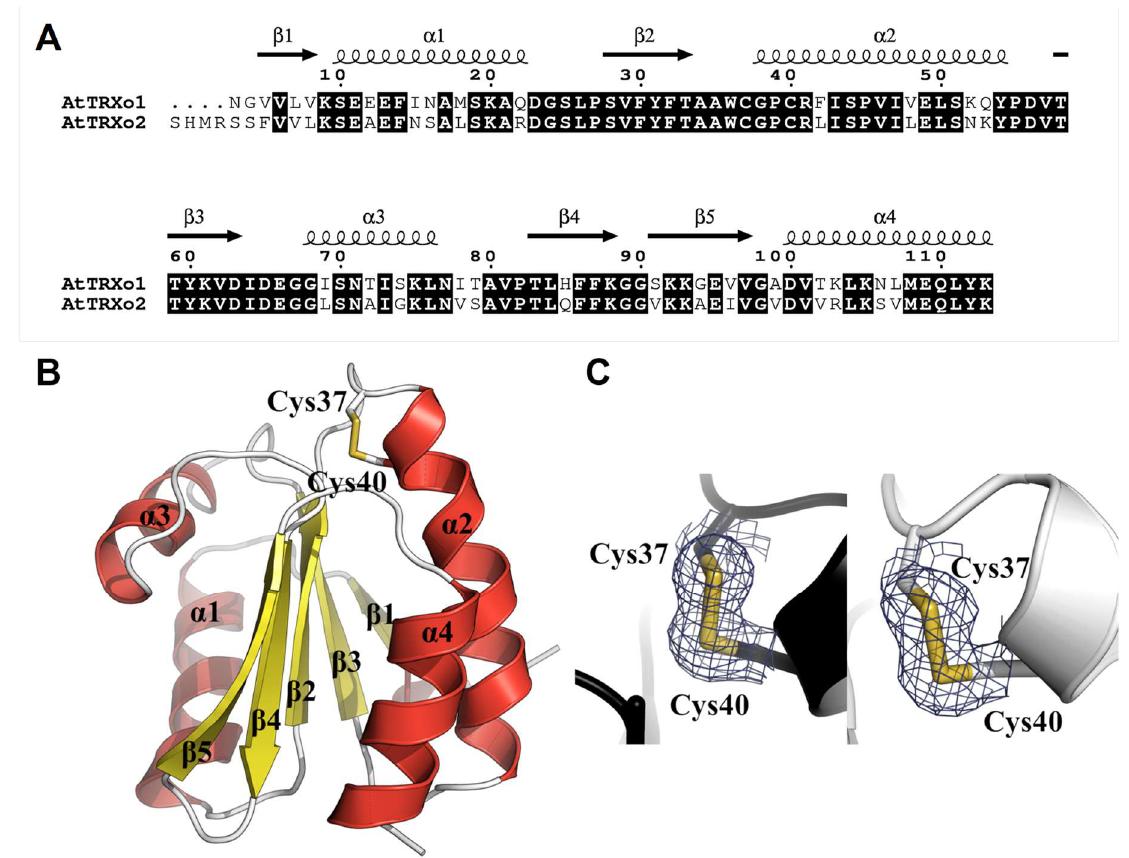
Figure 4. Three-dimensional structure and sequence conservation of oxidized Arabidopsis TRXo isoforms. ( A ) Structure-based sequence alignment of Arabidopsis TRXo isoforms. Conserved residues are highlighted in black. ( B ) Three-dimensional structure of AtTRXo2 at 1.50 Å resolution. The X-ray structure of AtTRXo2 is shown as a ribbon representation with helices in red and strands in yellow. In addition, the side chains of Cys 37 and Cys 40 residues are shown as sticks. ( C ) Electron density around the Cys 37 -Cys 40 disulfide bond. The maps shown are σ A-weighted 2 mF o - DF c maps contoured at 1.2 σ (0.07 and 0.38 e/Å 3 for AtTRXo1 and AtTRXo2, respectively). AtTRXo1 and AtTRXo2 are colored in white and black, respectively.